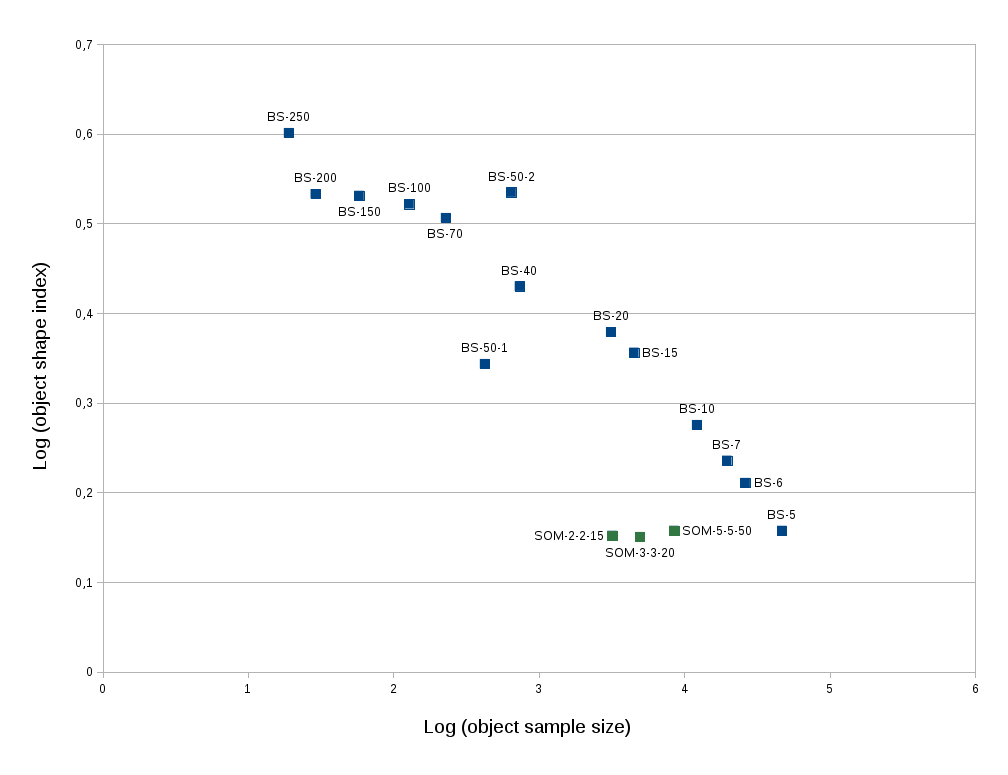
Figure 17. Log(Median) of the object shape index. The grid shape index is not represented because they are constant and equal to 0 in the Y